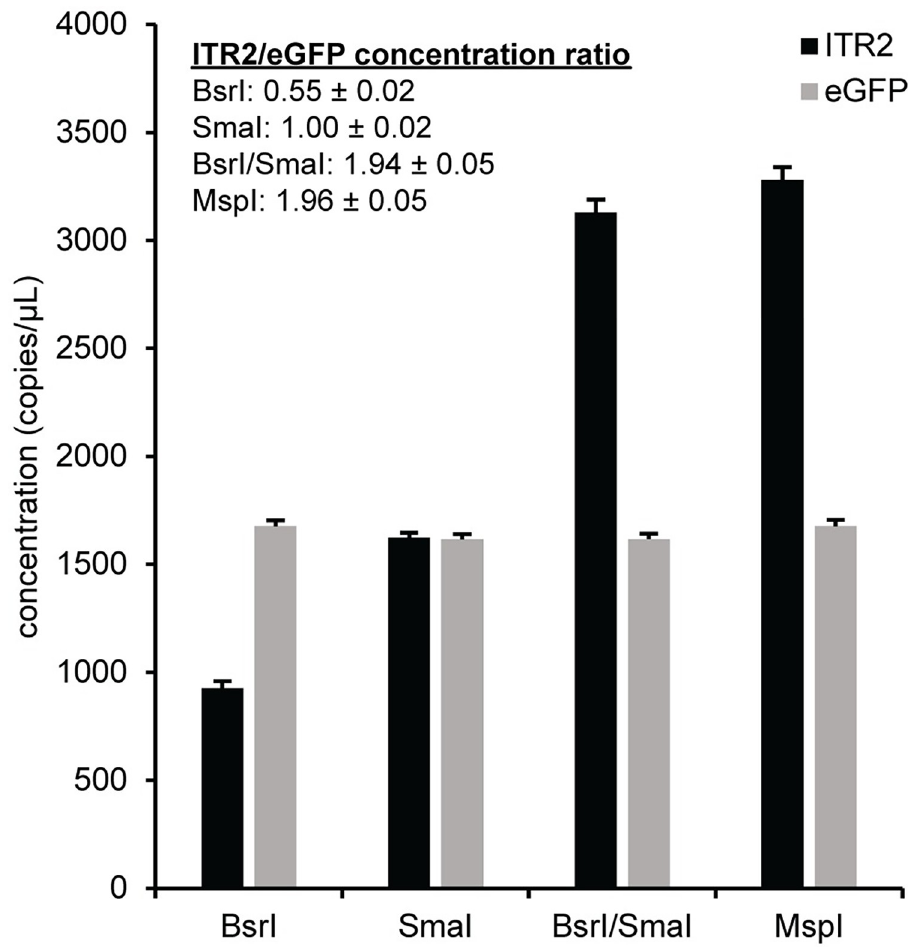
Fig 1. Enzyme effects on the ITR2 concentration. Prior to droplet formation, ddPCR reactions were prepared using a single-stranded vector genome plasmid, pssAAV2, and the indicated restriction nuclease or nucleases. The concentration of ITR and eGFP for each enzyme condition is indicated by the black and gray bars respectively. The ITR2 to eGFP concentration ratio is indicated. The reported numeric errors and error bars represent the 95% confidence